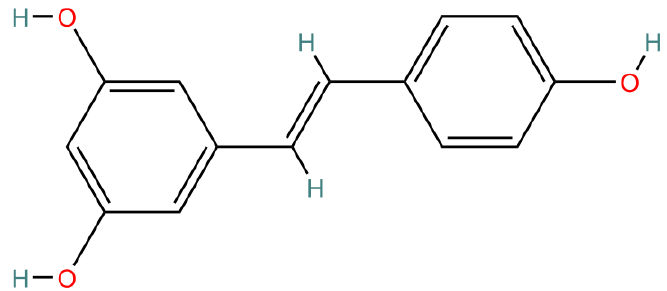
Figure 6. Resveratrol chemical structure. DMSO, 5-bromodeoxyuridine (5-BrdU) and Selisistat (Ex527) were obtained from Sigma (St. Louis, MO, USA). Dulbecco’s modified Eagle’s medium (DMEM)/F12, Hanks Balanced Salt Solution (HBSS), fetal bovine serum (FBS) and 0.25% trypsin were pur- chased from Hyclone (Logan, UT, USA). MitoTracker™ Red CM -H2XRos (M7513), Mito- Tracker™ Green FM (M7514), and LysoTracker Red DND -99 (L7528) were purchased from Invitrogen (Carlsbad, CA, USA). SOD detection kits were purchased from Dojindo (Shanghai, China). Assay kits for MDA and ATP were obtained from Nanjing Jiancheng Bioengineering Institute (Nanjing, China). Sirt1 and Sirt3 deacetylase fluorometric assay kits were obtained from Cyclex (Nagano, Japan). Fluorescent dye (JC-1) was obtained from Beyotime Biotechnology (Jiangsu, China). RIPA cell lysate was obtained from Bio- miga (San Diego, CA, USA). The following polyclonal primary antibodies were used in this study: anti-LC3, anti-Beclin1, anti-Sirt1, anti-Sirt3, anti-FoxO1 and anti-FoxO3a (Dan- vers, MA, USA), anti-p62, anti-PINK1, anti-Parkin (Cambridgeshire, UK). FITC-conju- gated anti-rabbit antibody was purchased from Millipore (Darmstadt, Germany). Reverse transcription kit was purchased from Takara (Tokyo, Japan). The qPCR kit was from Kapa Biosystems (Boston, MA, USA). All other chemicals used in this research were of analyti- cal grade. 4.2. Cell Culture and H/R Treatment Sprague – Dawley rats (1-day-old) were purchased from the Center of Experimental Animal in the Academy of Military Medical Sciences, China. All experimental animal pro- cedures were approved by the Biological and Medical Ethics Review Committee of the Minzu University of China (1 September 2017) and followed the national ethical guide- lines for laboratory animals in China. Spontaneously beating neonatal rat cardiomyocyte cultures were obtained from 1-day-old Sprague – Dawley rats as previously described [45]. To establish an in vitro model of H/R, the cardiomyocytes were cultured in glucose-free anoxic HBSS and transferred to a tri-gas incubator (Thermo Fisher, Waltham, MA, USA) at 37 °C in an atmosphere of 94% N 2 , 5% CO 2 and 1% O 2 . After 12 h, the medium was replaced with fresh DMEM/F12 supplemented with 10% FBS, and the cardiomyocytes were cultured at 37 °C in the normoxic incubator (95% air and 5% CO 2 ) for 12 h of reoxy- genation. 4.3. Experimental Groups and Treatments The neonatal primary rat cardiomyocytes that had been cultured for 96 h in a single layer with good synchronous beating were randomly and evenly divided into the follow-